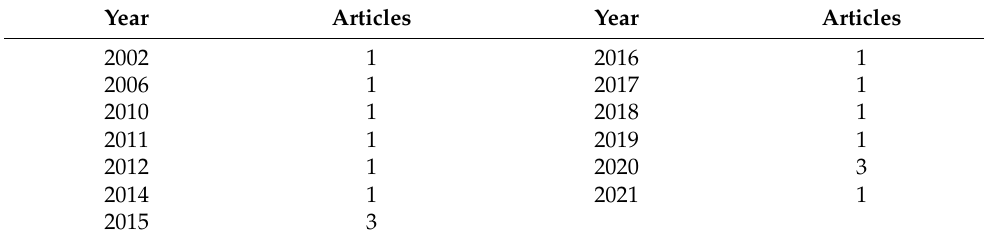
Table 3. Number of articles published per year.